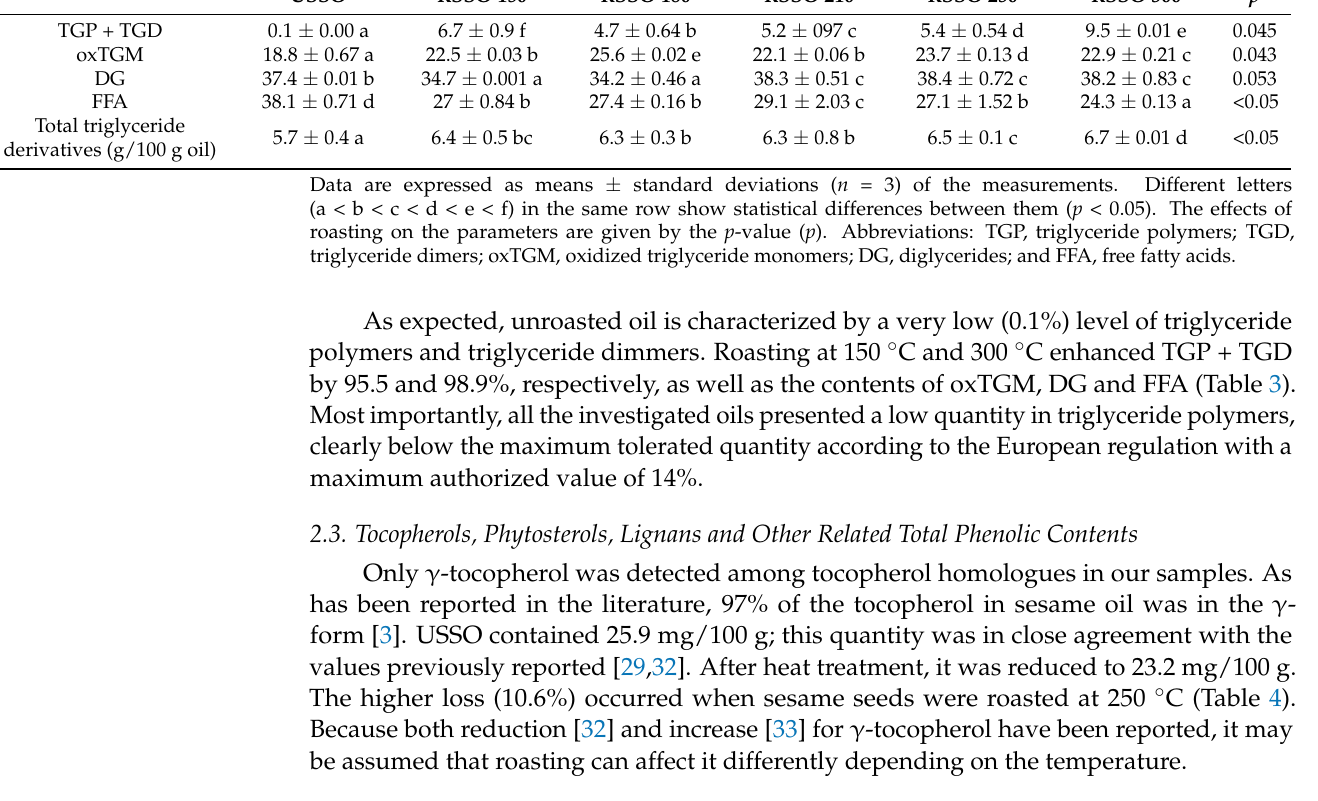
Table 4. γ -tocopherol, lignan (sesamin, sesamolin) and total phenolic compounds (TPC) contents in row and roasted sesame oils at different